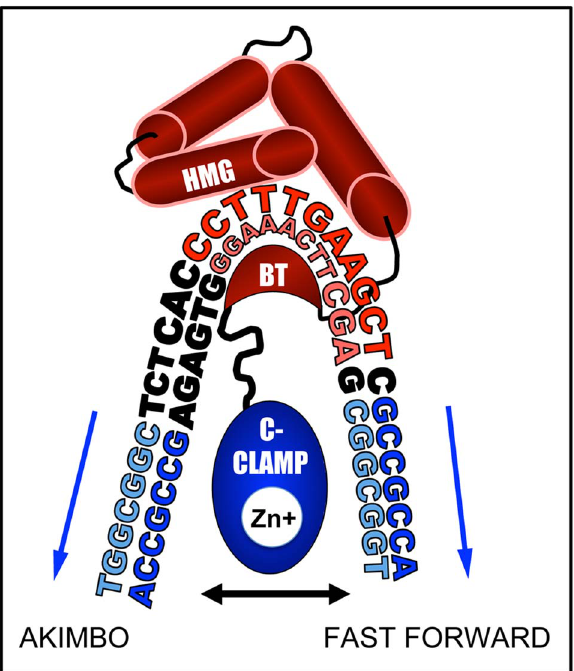
Figure 10. DNA bending by the HMG domain could explain preferential binding for AK6 and FF0 configurations. A cartoon based on the NMR-deduced structure of the HMG domain and basic tail (BT) of murine LEF-1 [80] bending the HMG site. The HMG domain is composed of three alpha-helices (red barrels), the first of which binds the minor groove of the HMG site (shown in red), while the BT (red crescent) wraps around to make contact with the major groove. This binding induces a sharp bend in the DNA, most pronounced between positions T3 and T4 (CC TT TGATCTT). In TCF/Pan, which shares 92% identity with the HMG domain of LEF1, the BT is followed by a 10 residue linker, and then by the C-Clamp (blue oval), recently shown to chelate a zinc ion [48]. The C-clamp can bind to Helper sites (blue sequences) either upstream (AK) or downstream (FF) of the HMG site. We postulate that the linker places a constraint on the optimal spacing for the FF and AK orientation of 0 and 6 bp, respectively.